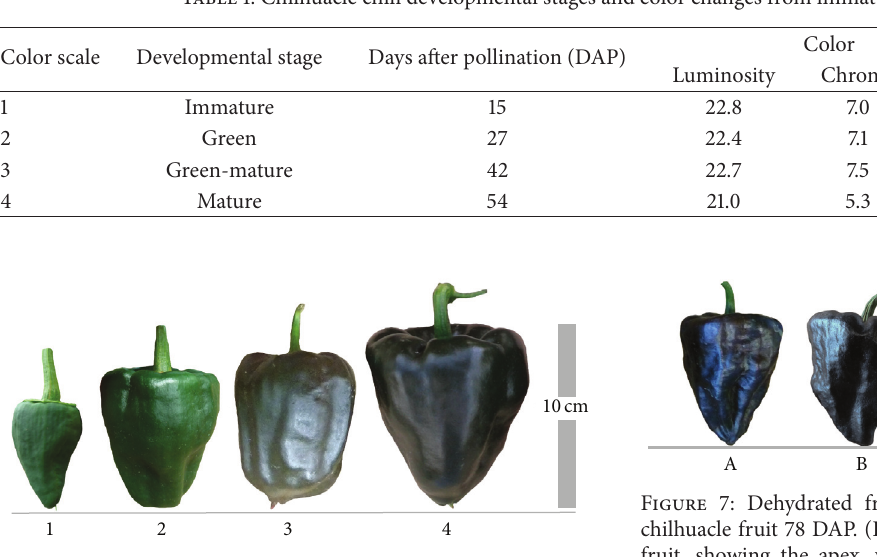
Figure 6: Color changes from immature to mature fruits of chilhuaclechili:(1)Immaturefruit.(2)Greenfruit.(3)Greenmature fruit. (4) Mature fruit.